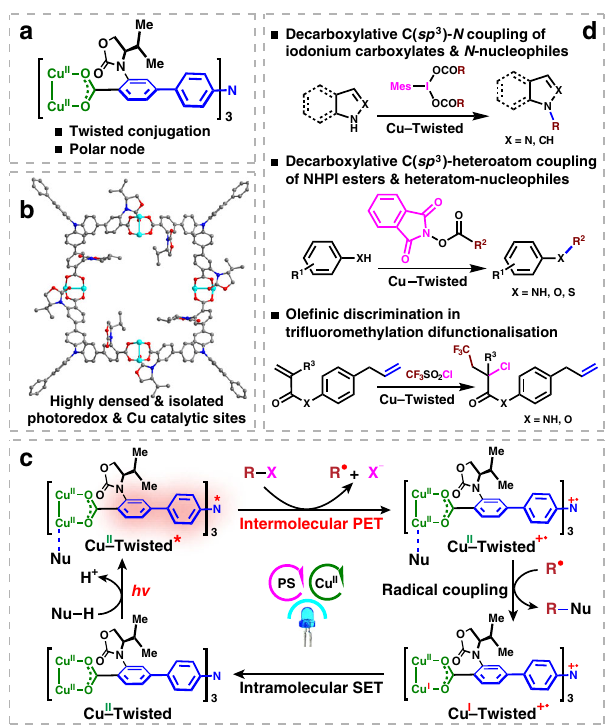
Fig. 1 Diode-like Cu(II) – dye recti fi er for synergistic photoredox and copper catalysis. Schematic illustrations of a the steric-induced twisted conjugation between polar Cu(II) – carboxylate node and photoreductive TPA -moiety and b the densed fi xation and spatial isolation of photoredox and Cu(II) sites in coordination polymer. c The mechanistic perspective of synergistic catalysis by Cu(II) – dye, and d the heterogeneous catalytic